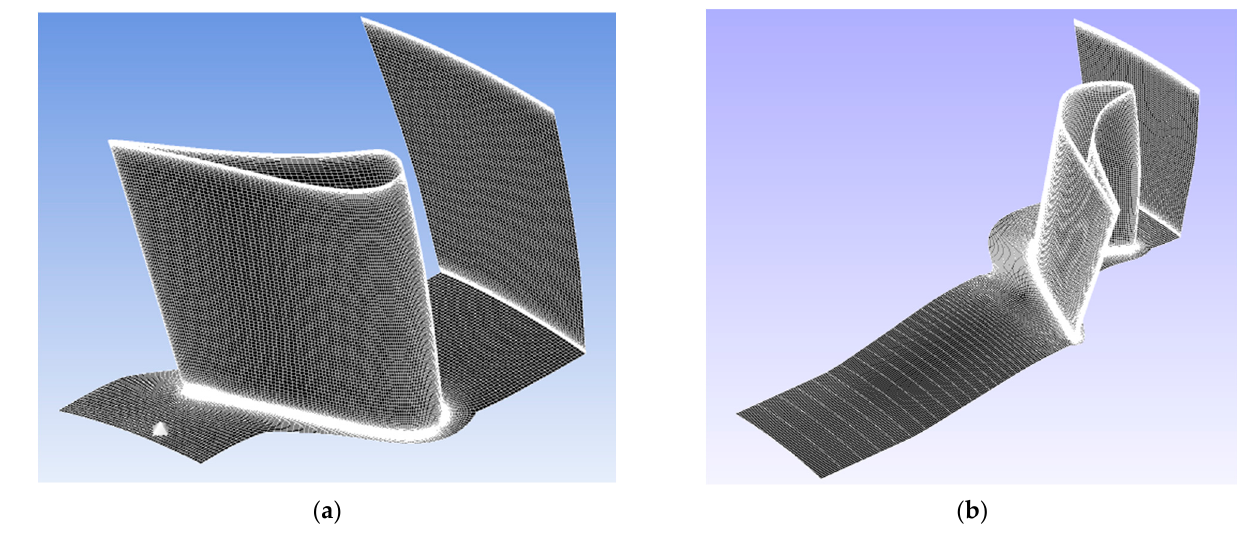
Figure 2. Computational meshes of the stator ( a ) and rotor ( b ) blade rows after grid-dependence study.